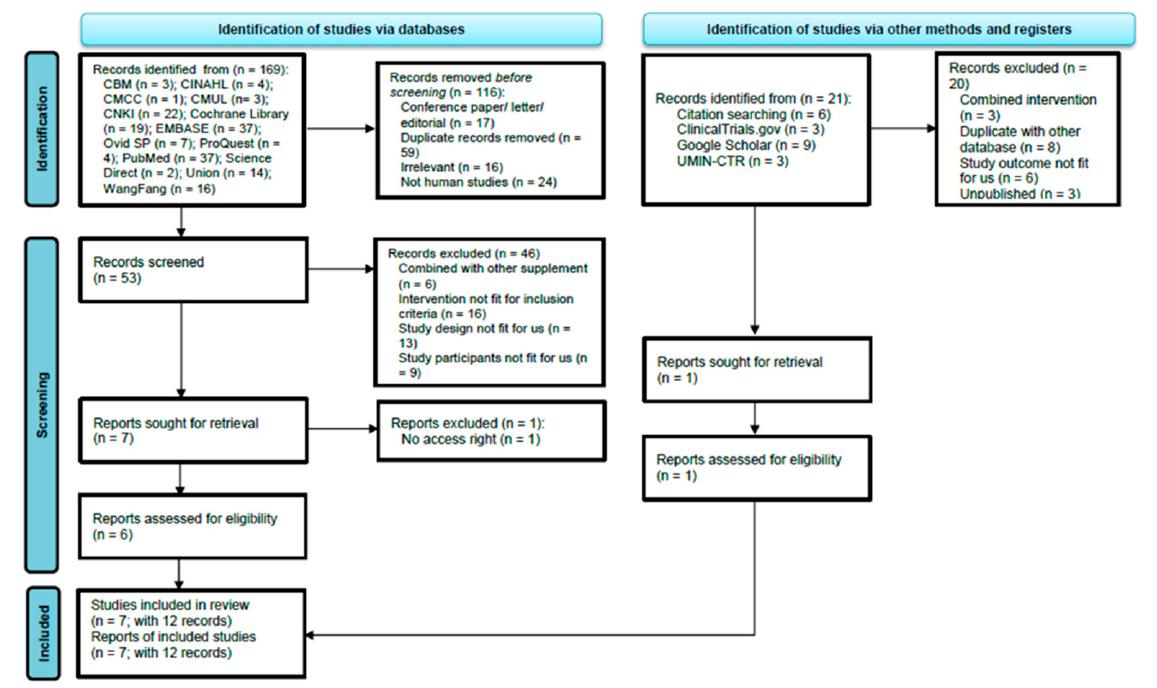
Figure 1. PRISMA flow diagram of searching and selection of the articles . Note. CBM: Chinese Biomedical Literature Database; CINAHL = Cumulative Index of Nursing and Allied Health Literature; CMCC = Chinese Medical Current Content; CMUL = Capital Medical University Library; CNKI: China National Knowledge; EMBASE: Excerpta Medica database; UMIN-CTR: University Hospital Medical Information Network Clinical Trials Registry .